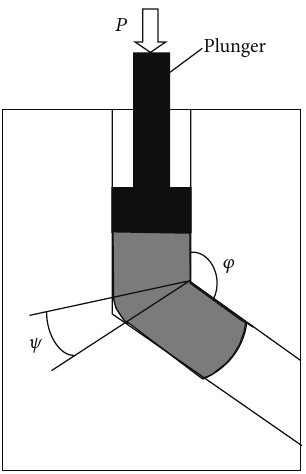
Figure 1: Schematic illustration of the ECAP process [33].